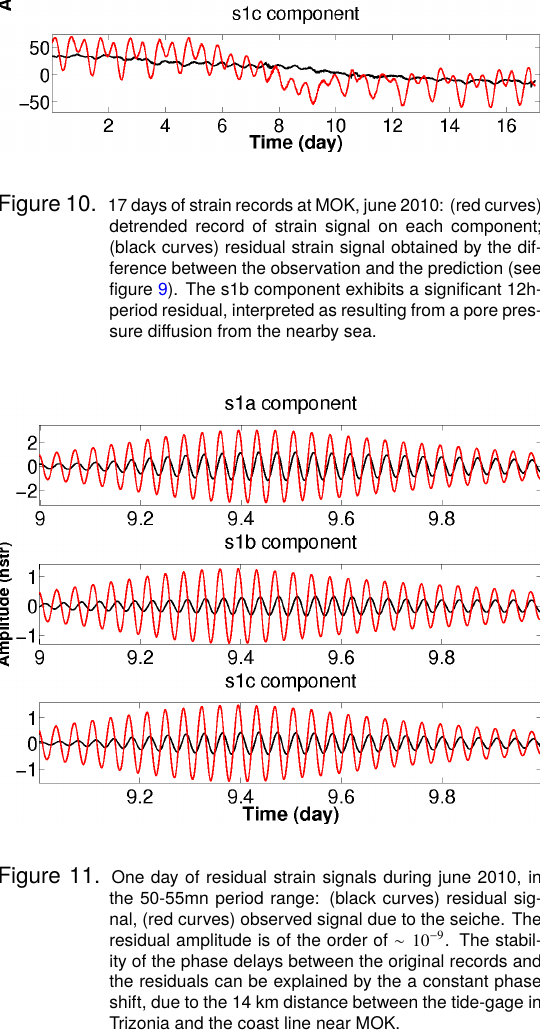
a good estimation of the solid tide. However, the stability of the phase delay between the residuals and the observations for each frequency range, seems to indicate that the correction could be improved by taking into account a transfer function related to a simple pore pressure diffusion process from the